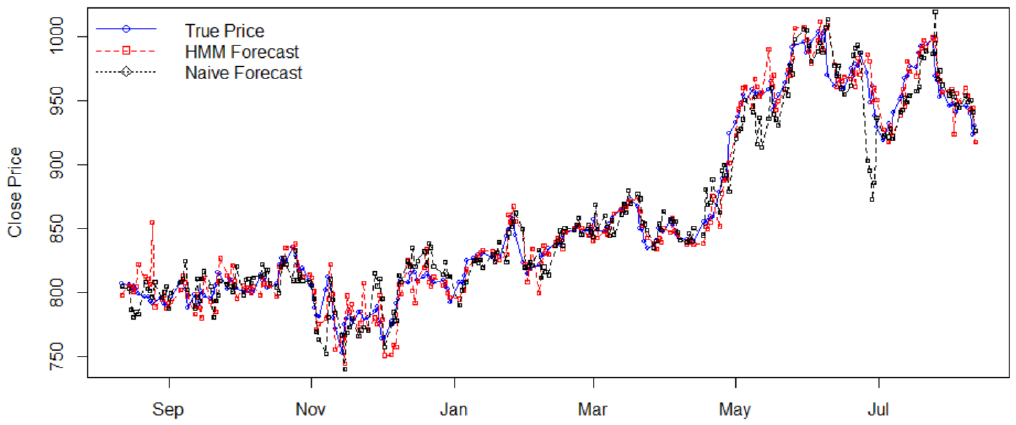
Figure 8. HMM prediction of Google stock daily close prices from 15 August 2016 to 11 August 2017 using two-states HMM and the naïve